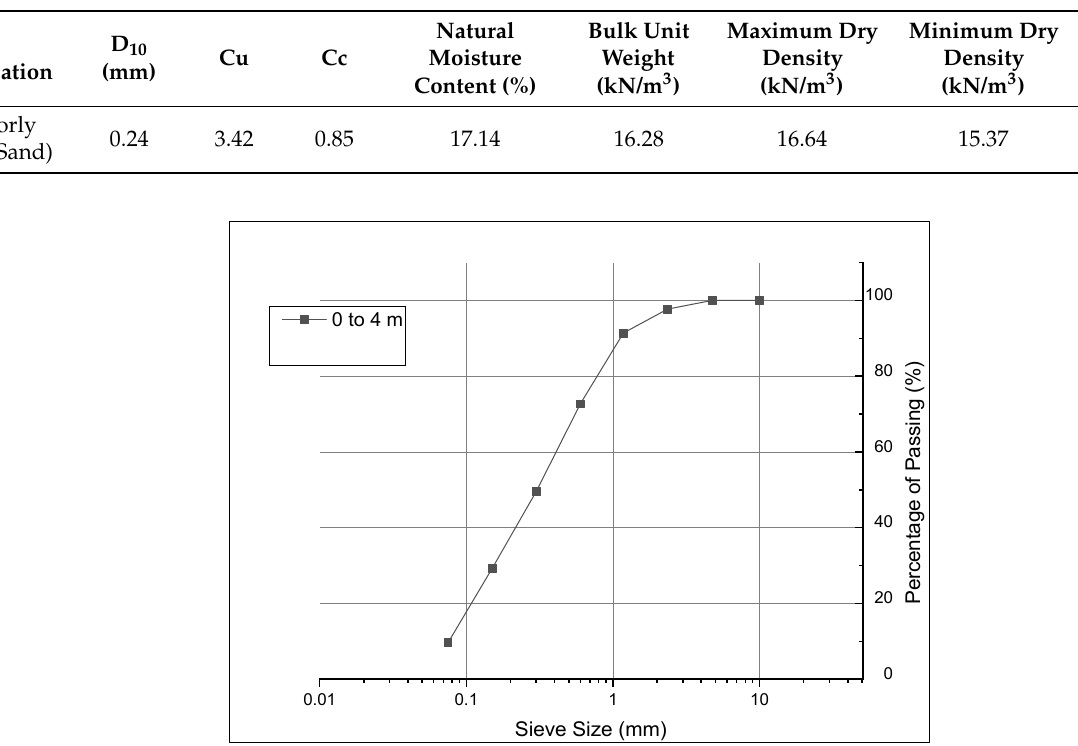
Figure 6. Particle size distribution of the